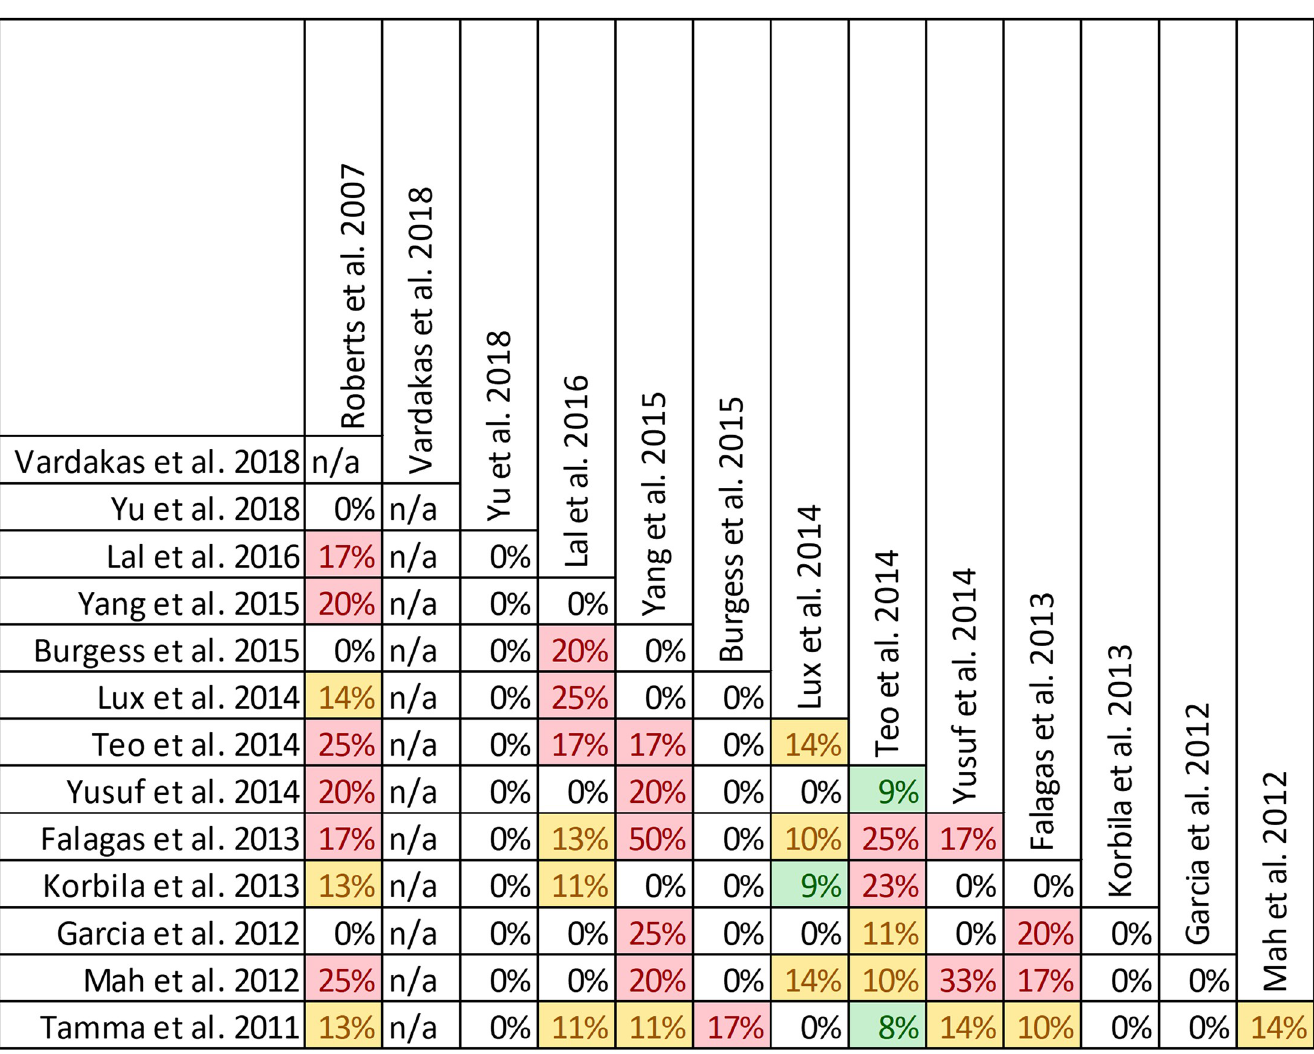
Fig 15. Pairwise CCA for reviews reporting adverse events or prolonged versus intermittent infusions of beta-lactams. Colors indicate degree of overlap, as calculated with CCA, for visual clarity. White = � 5%, green 5.1–9.9%, yellow 10–14.9%, red � 15%. N/A indicated where primary studies included were not reported by systematic